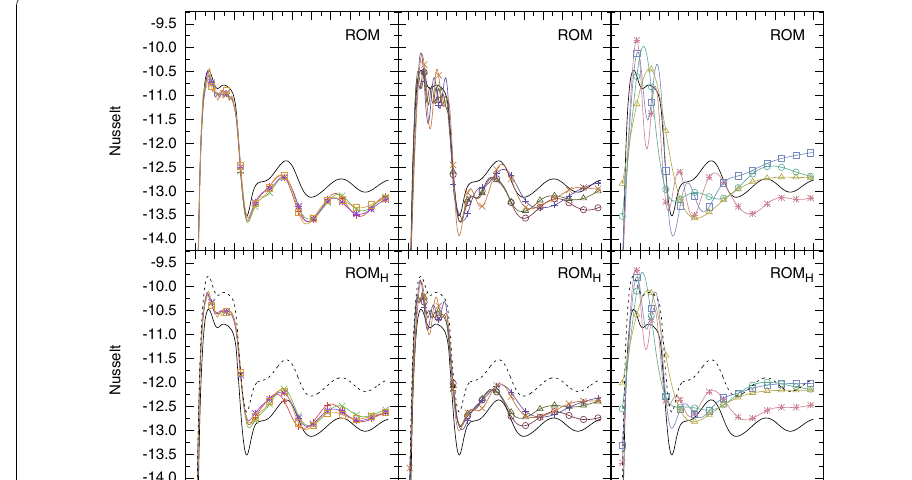
include a FOM solution (labeled FOM H ) using the coarser mesh to evaluate how the hyper-ROM formulation relates to a FE mesh